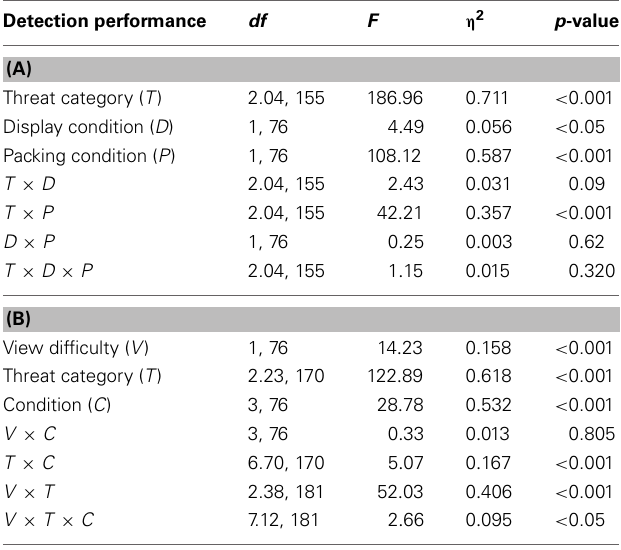
Table 1 | Results of the ANOVAs conducted with detection performance (A (cid:2) ) as dependent variable 4 .